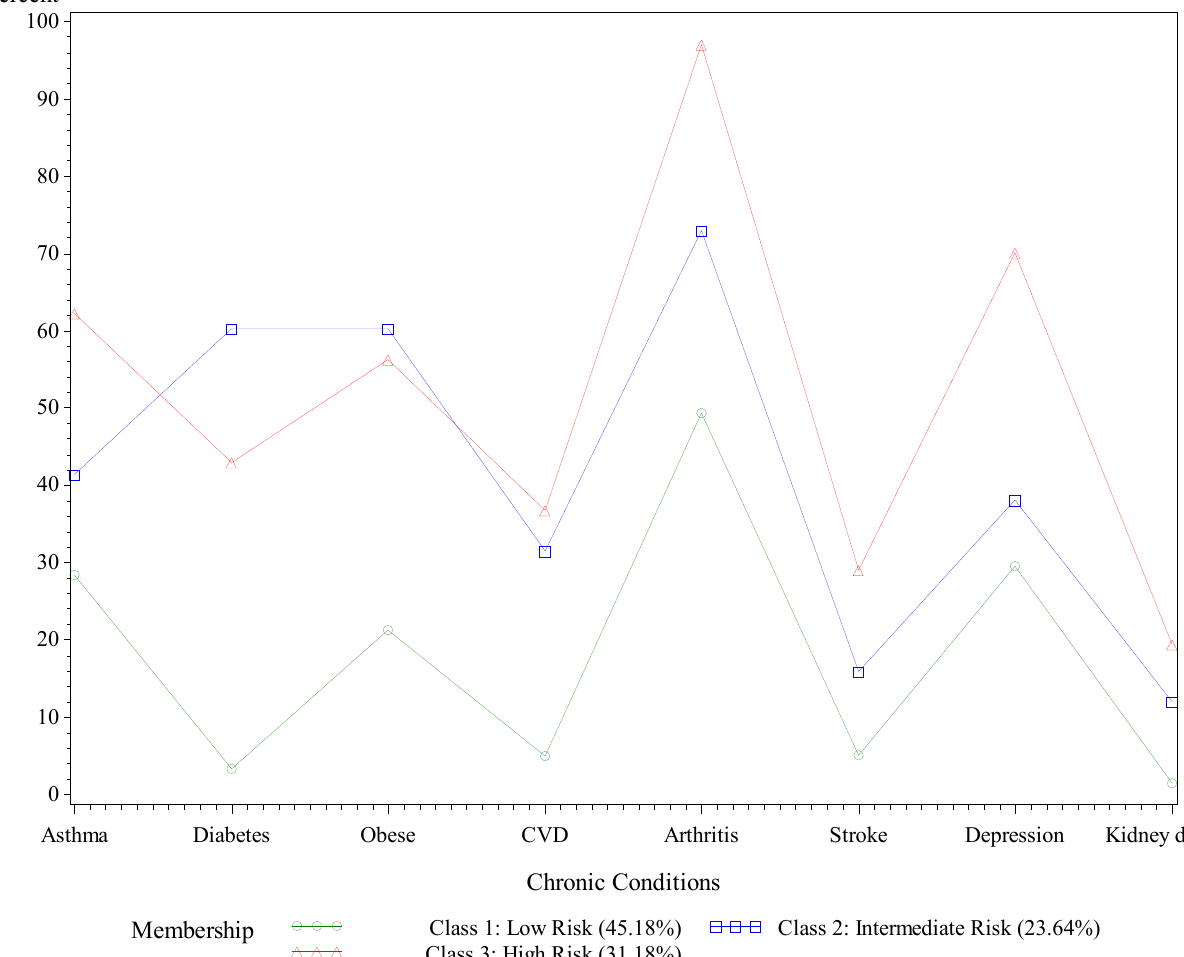
Figure 2. Probabilities of chronic health condition by latent class, AL adults with COPD, BRFSS, 2015–2019. Comorbid health conditions are defined as having ever been told by a health professional that respondents had the condition of asthma, diabetes, obesity, cardiovascular disease (CVD), arthritis, stroke, depressive symptoms, or kidney disease.